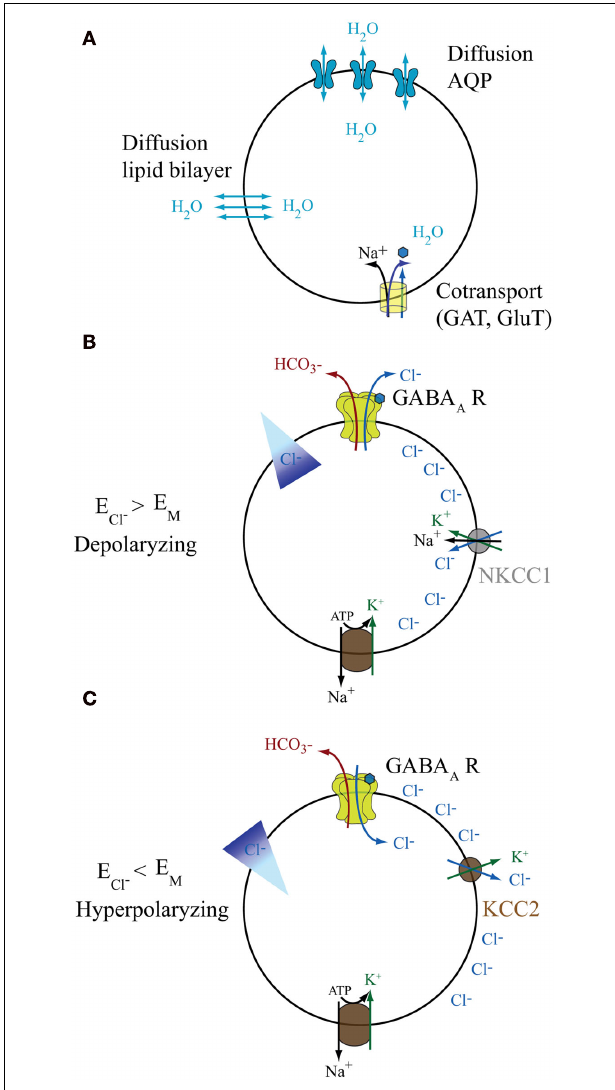
FIGURE 1 | Basic properties of water and anions fluxes. (A) Water can diffuse according to the osmotic pressure through the membrane lipid bilayer or via the dedicated channels AQP. Additionally it can be transported against its gradient by cotransporters, such as those for GABA and glutamate that use the driving force of Na + to move the neurotransmitters and eventually water against their gradient. (B,C) The activity of different transporters and exchangers determines the steady-state gradient for Cl − and consequently regulates the E Cl . Cl − transport via cation–chloride cotransporters is fueled by the Na + and K + gradients generated by the Na–K ATPase.Two of the major players in neural cells are NKCC1 and KCC2, by which Cl − is transported inside and outside the cells respectively.When E Cl (see Box 1 ), is more positive that the E M , opening of GABA A R would mediate an efflux of Cl − (for convention called inward current) that depolarizes the cells (B) . Conversely when E Cl is more negative that the E M , GABAergic currents (outward) bring the membrane potential close to these values and are hyperpolarizing (C) . In this case to determine the E GABA is important to consider also the flux of HCO − since GABA A Rs are permeable 3 to this anion. Due to its higher level inside the cells, opening of GABA A R would drive a depolarizing efflux of HCO − that, counteracting the influx of 3 Cl − , contributes to deviate E GABA to value more positive than that of HCO − 3 (For Rev, see Andrew et al., 2007; Blaesse et al., 2009; Risher et al.,